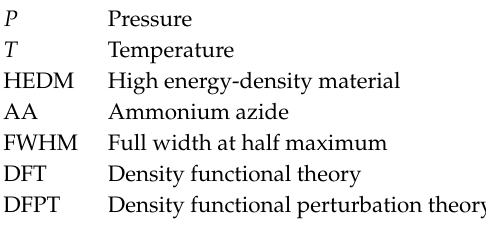
Figure S2: Experimental paths mapped in the nitrogen phase diagram; Figure S3: Photographs of the sample chamber and Raman spectrum of AA + N 2 along path 1; Figure S4: Raman spectrum at different positions in the sample chamber at 12.6 GPa–300 K after the decomposition of AA in liquid N 2 at 700 K; Figure S5: Raman spectrum of AA + N 2 collected along path 2; Figure S6: Raman spectrum of phase A upon heating to 650 K around 20 GPa; Figure S7: Comparison of Raman spectra in paths 2 and 3; Figure S8: Raman spectrum of phase A at different positions in the sample chamber; Figure S9: Raman spectrum of phase A upon decompression at 300 K; Figure S10: Extended Raman spectra of phase B and comparison with NH 4 and NH 5 ; Figure S11: XRD pattern (a) and image (b) of phase A (a); Figure S12: Measured cell parameters and volume of N 2 and NH 3 solids mixed with phase A as a function of pressure at 300 K; Figure S13: XRD pattern of the AA + N 2 sample at 20.1 GPa–300 K after the high P - T transformation; Figure S14: XRD pattern of the pure AA sample at 15.9 GPa–300 K after the high P - T transformation; Figure S15: Comparison between the experimental XRD patterns of phases A at 20.1 GPa–300 K and Phase B at 15.9 GPa–300 K, with the theoretical ones of N 4 H 4 , N 6 , N 8 , N 8 H, N 9 H, HN 3 and NH 4 N 5 at 20 GPa–0